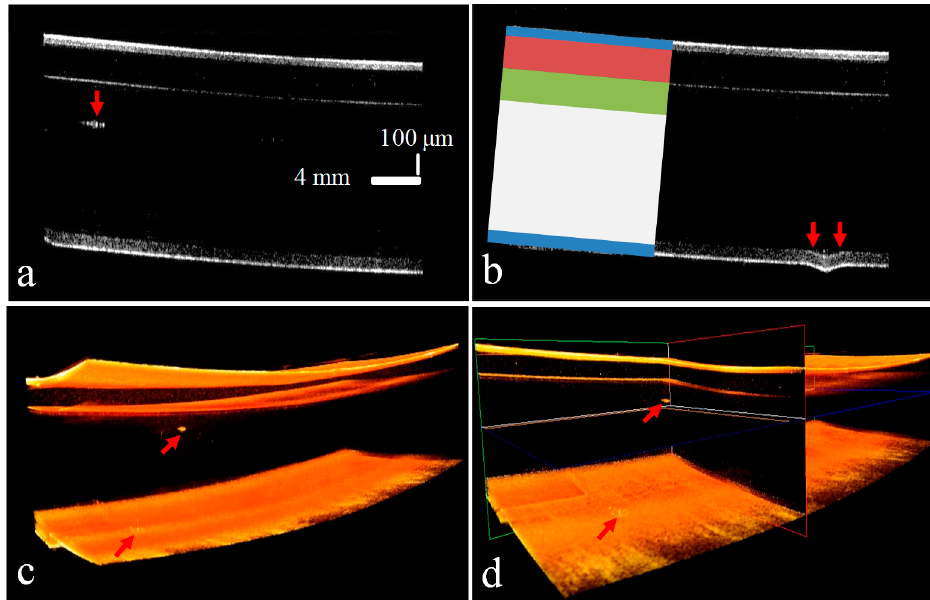
Figure 7. Results of sample head-1 of the SD-OCT-1 system with defects are indicated with red arrows: ( a ) cross-section view through sample head-1 where the defect in the glass layer can be seen clearly; ( b ) defect in the bottom layer; ( c ) 3D scan result of the defect; and ( d ) ortho-sliced view of defect identified in ( a ).